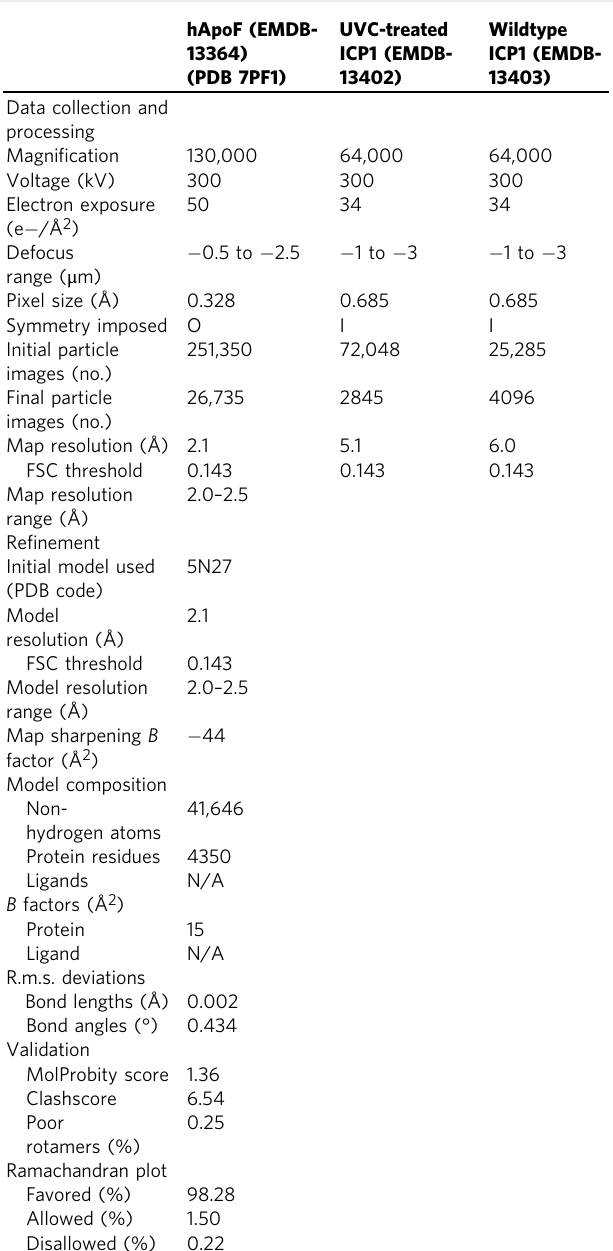
Table 1 Cryo-EM data collection, re fi nement and validation